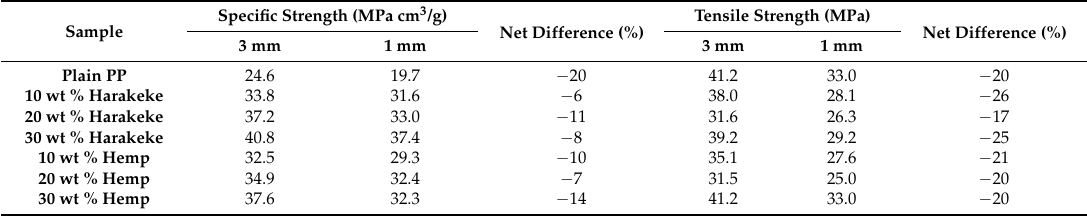
Table 2. Comparison of specific strength values for 3 mm printing and 1 mm printed filament. Table 3. Comparison of specific modulus values for 3 mm printing and 1 mm printed